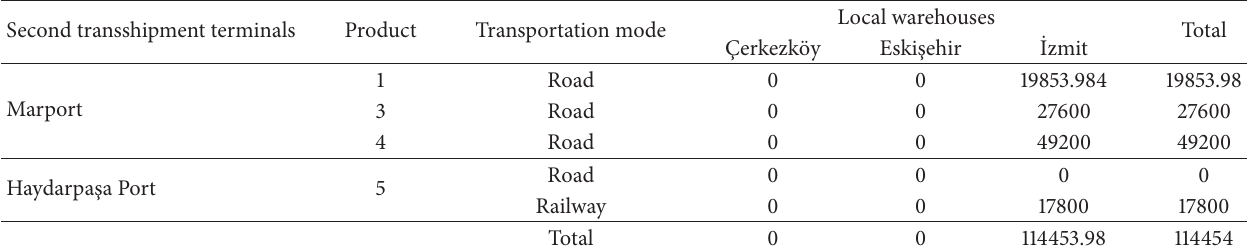
Table 23: Transportation quantities from the second transshipment terminals to local warehouses.